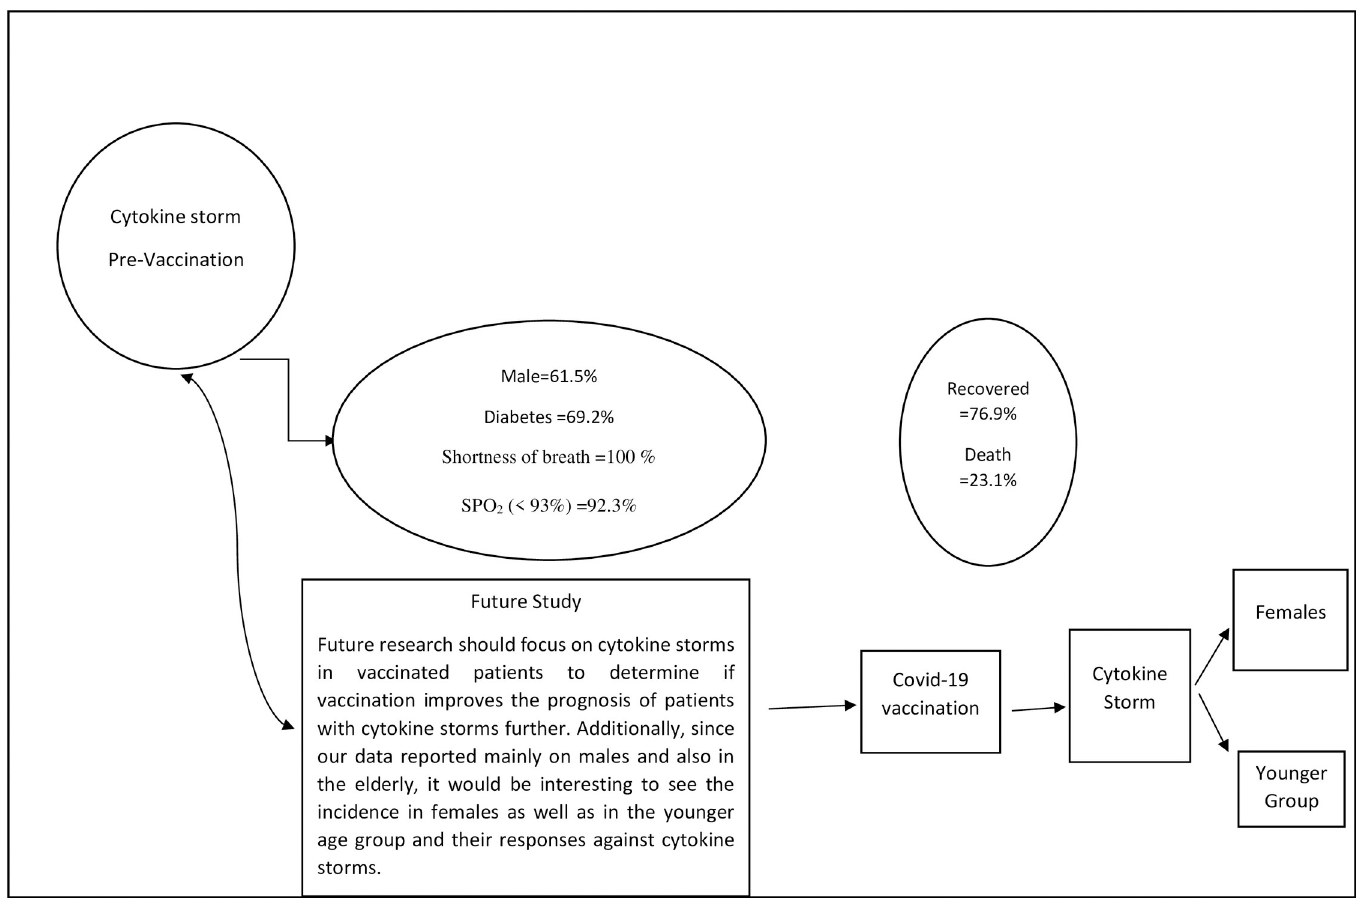
Fig 2. Summary of the study and future